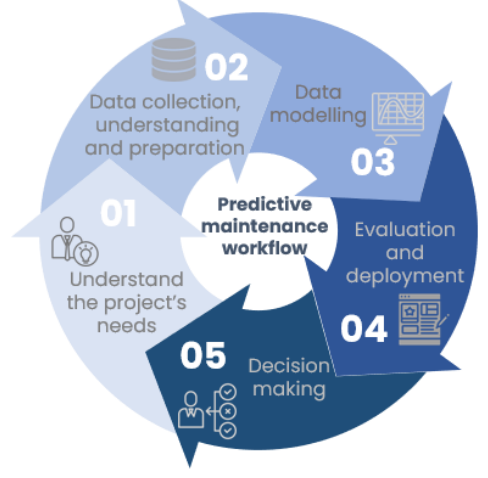
Figure 2. Predictive maintenance workflow